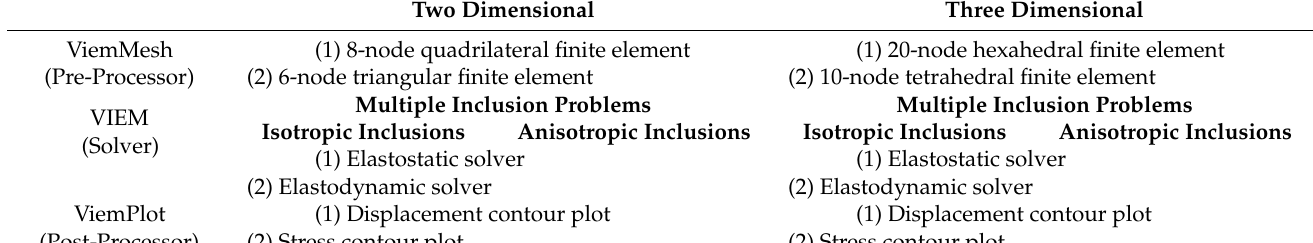
Table 1. Capabilities of VIEMAP.